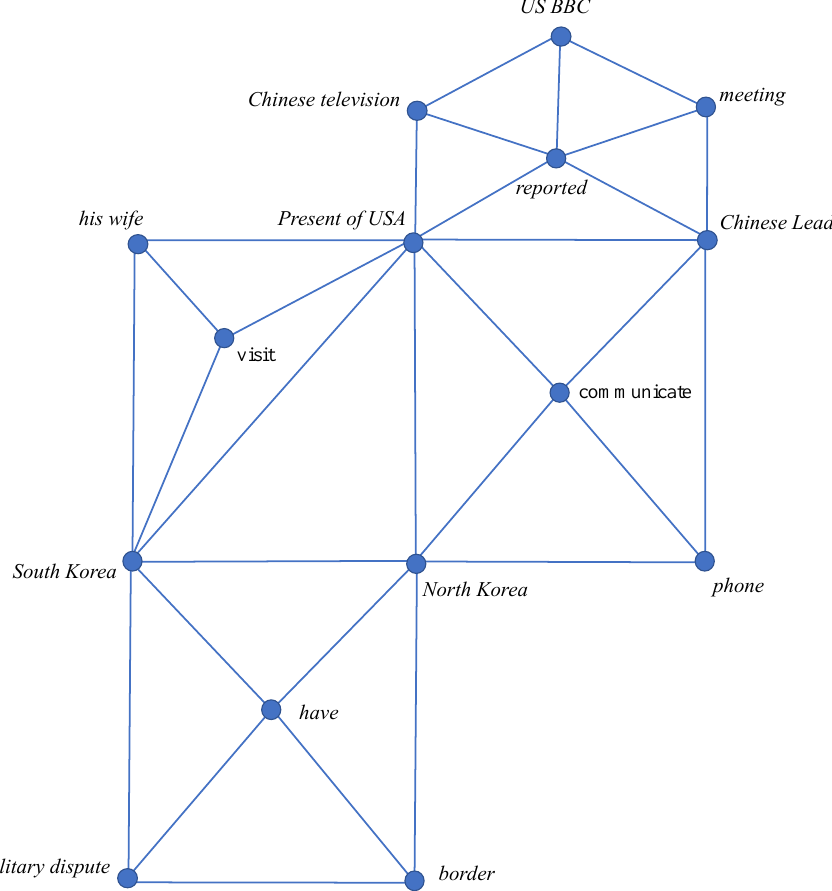
Figure 2. The event connection graph formed from given sentences.